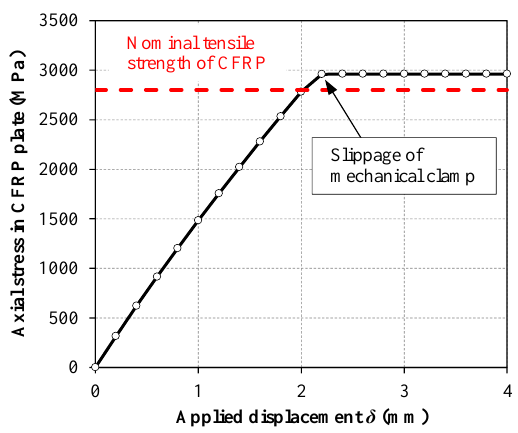
Figure 3. Finite element (FE) results: axial stress vs. applied displacement to carbon fiber reinforced polymer (CFRP) free edge mechanically clamped to steel substrate.